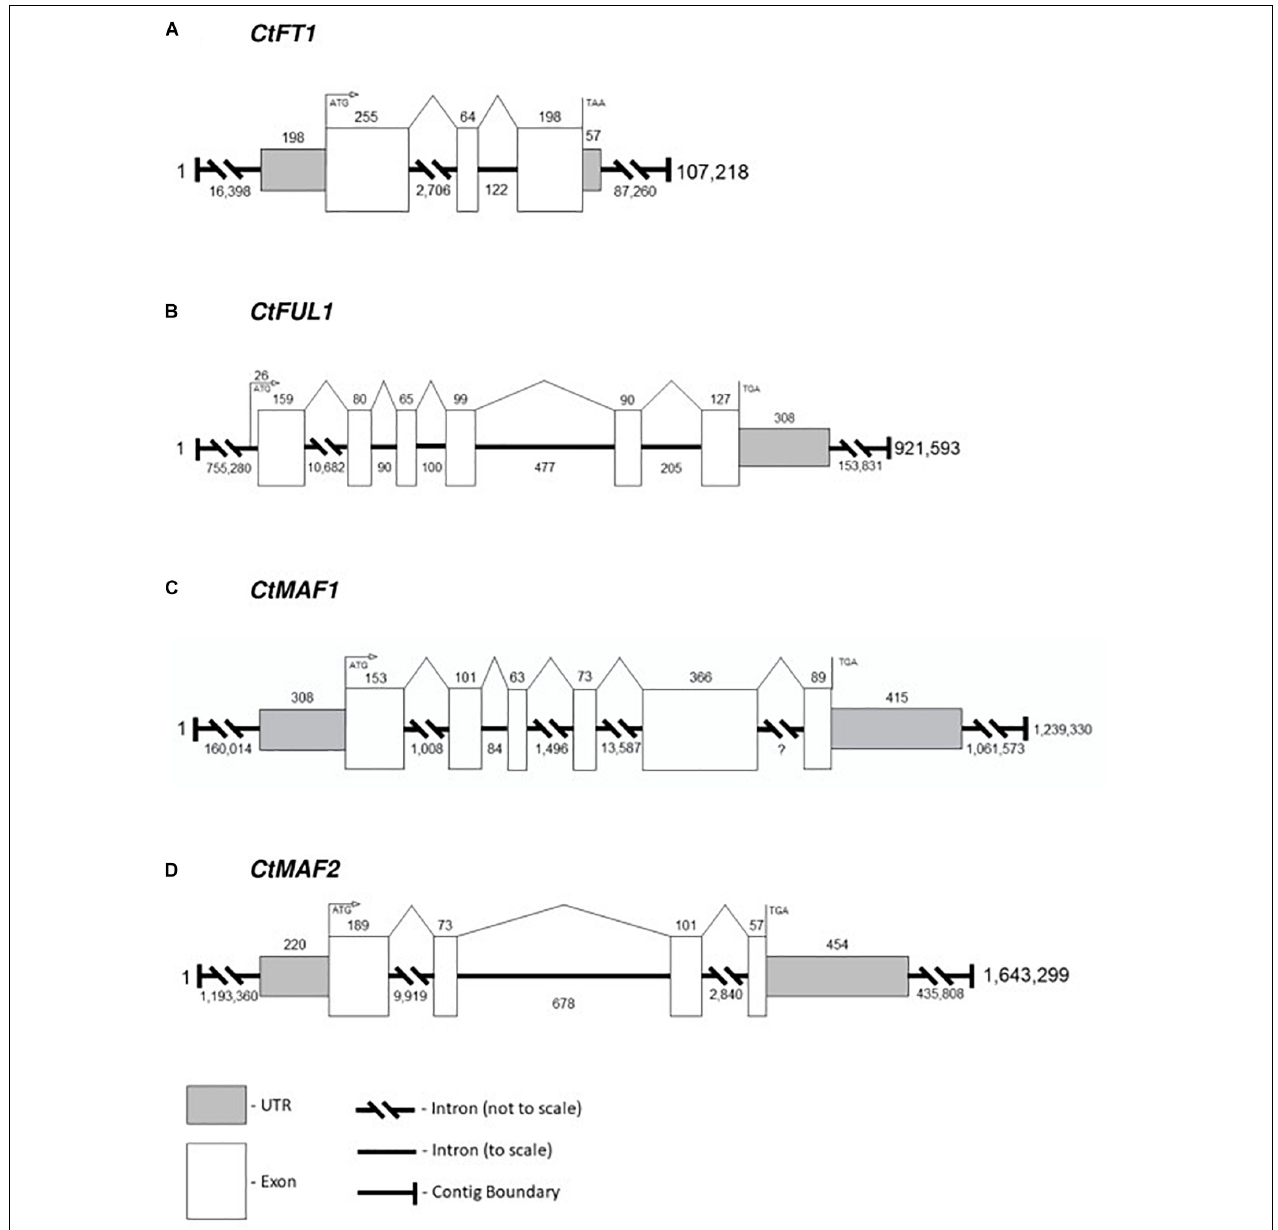
FIGURE 6 | Gene models for (A) CtFT1 , (B) CtFUL1 , (C) CtMAF1 , and (D) CtMAF2 based on alignments of transcript with the genome assembly of